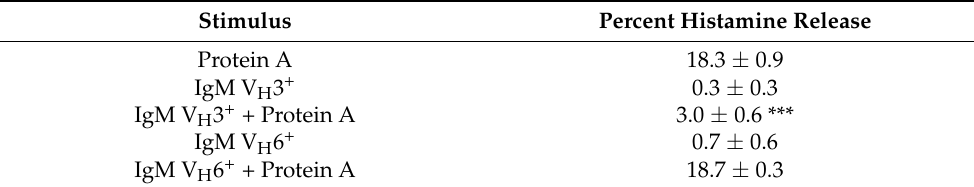
Table 3. Effects of preincubation of protein A with human monoclonal IgM V H 3 + or IgM V H 6 + on the activation of